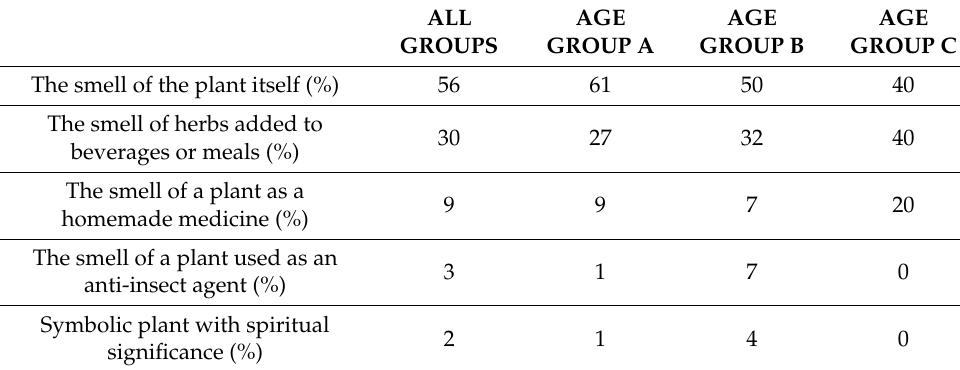
Table 4. The significance of favorite herbs and their smell.